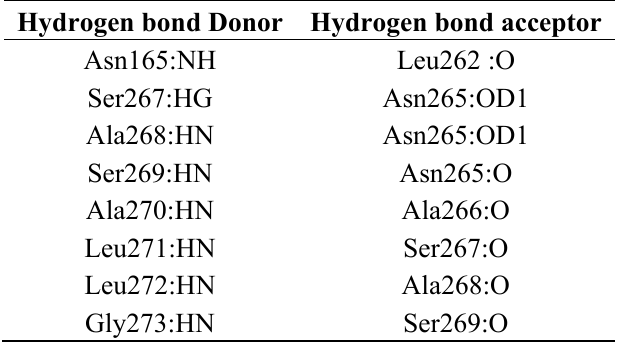
Table 2. The hydrogen bonds between residue 265 and residue 273.